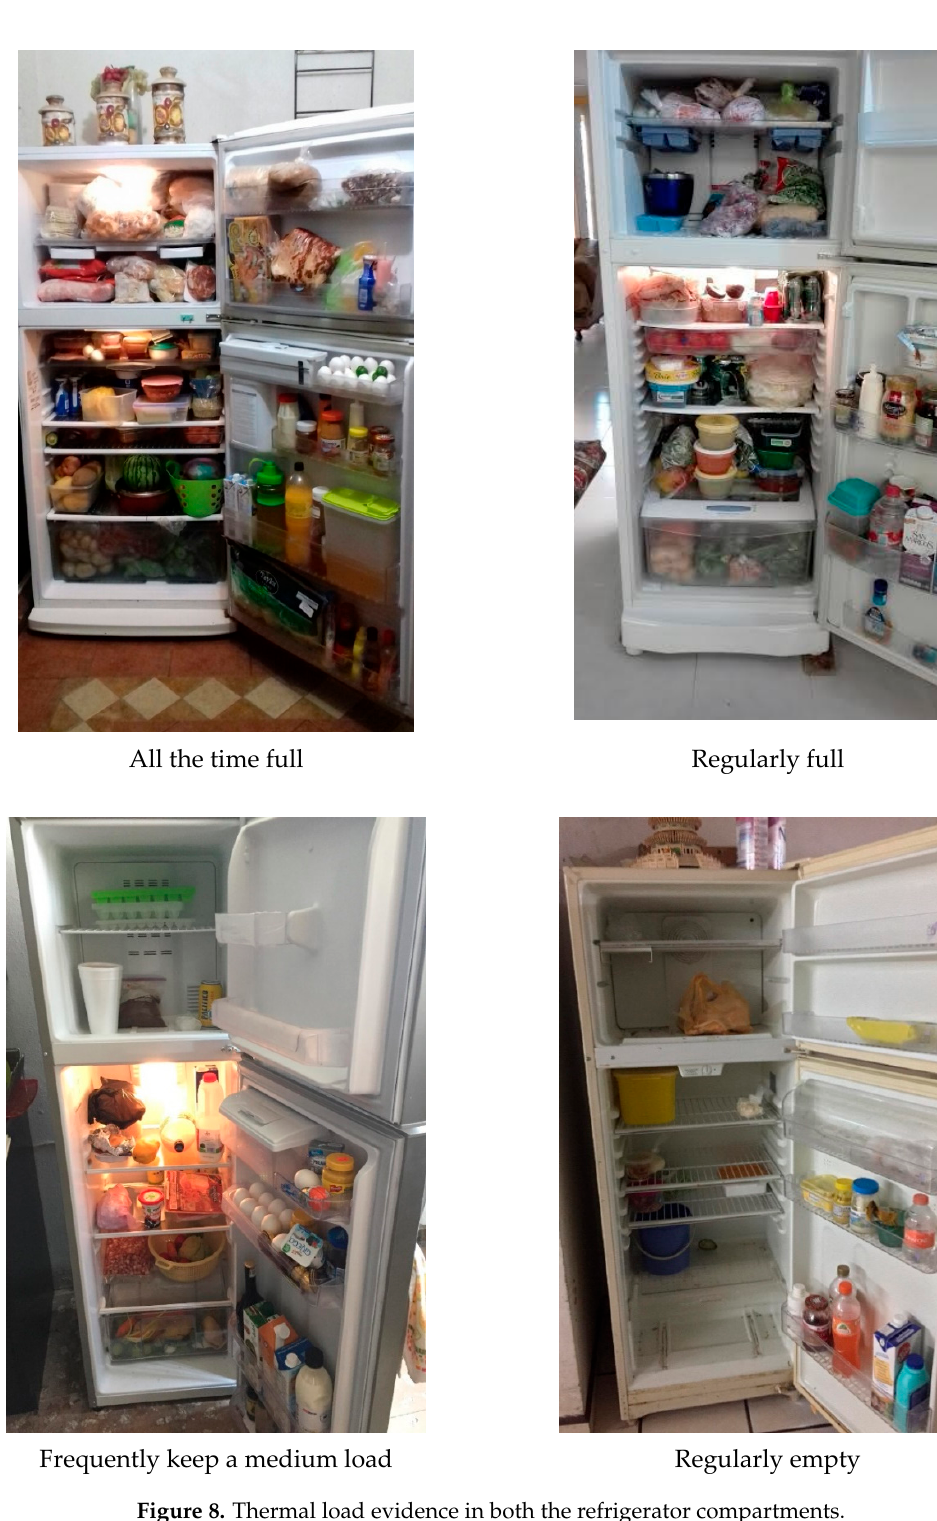
Figure 8. Thermal load evidence in both the refrigerator compartments.